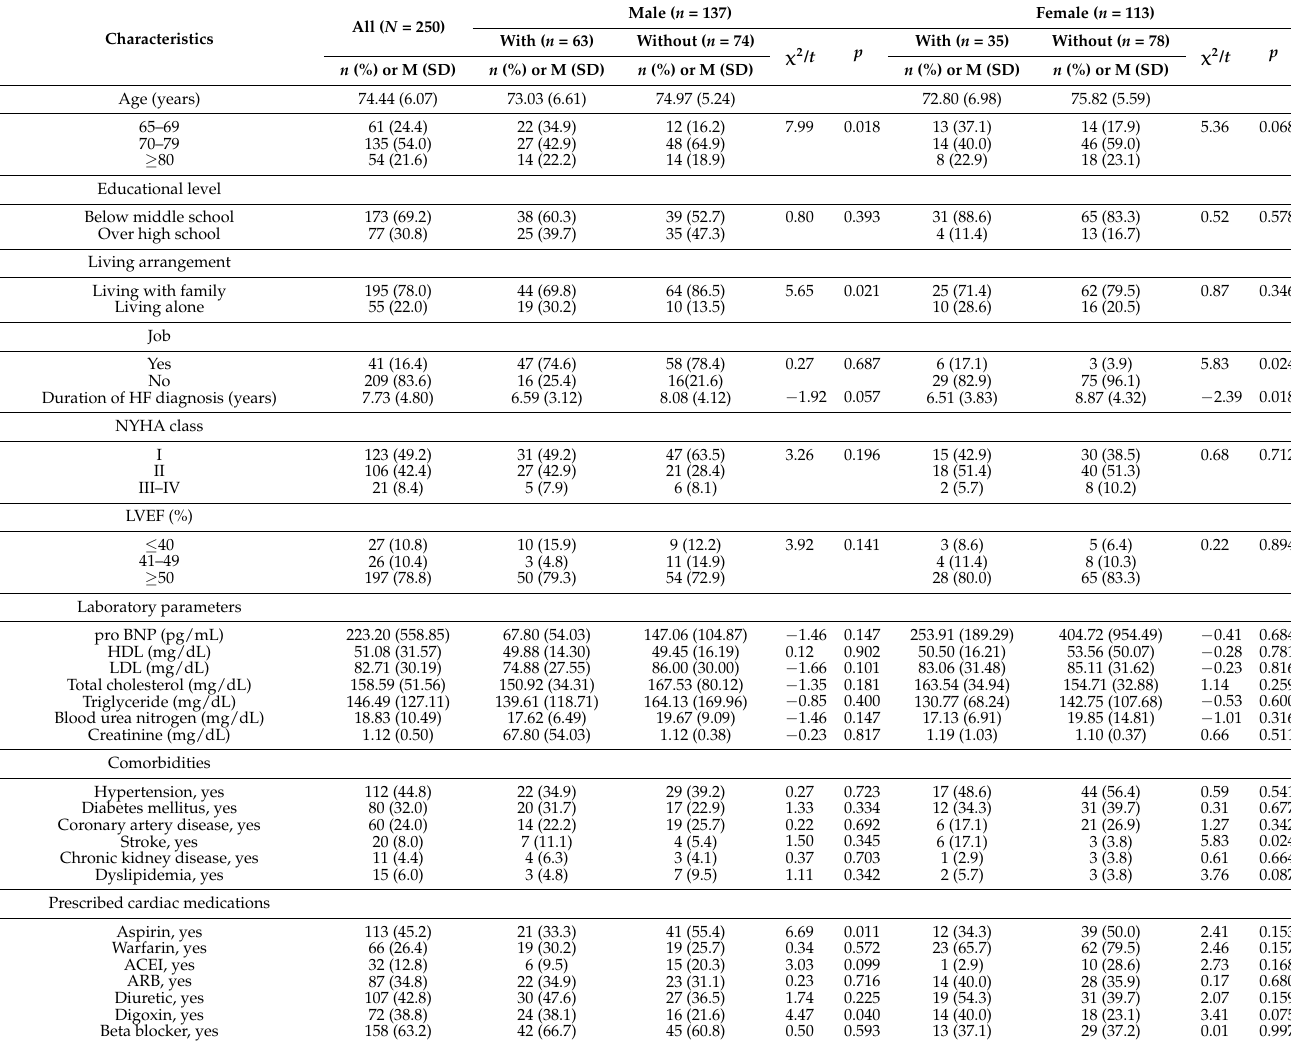
Table 1. Baseline characteristics of older patients with heart failure (HF) by atrial fibrillation (AF) status.